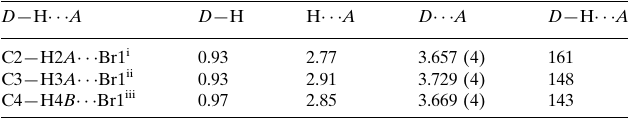
Hydrogen-bond geometry (A˚ , (cid:3)